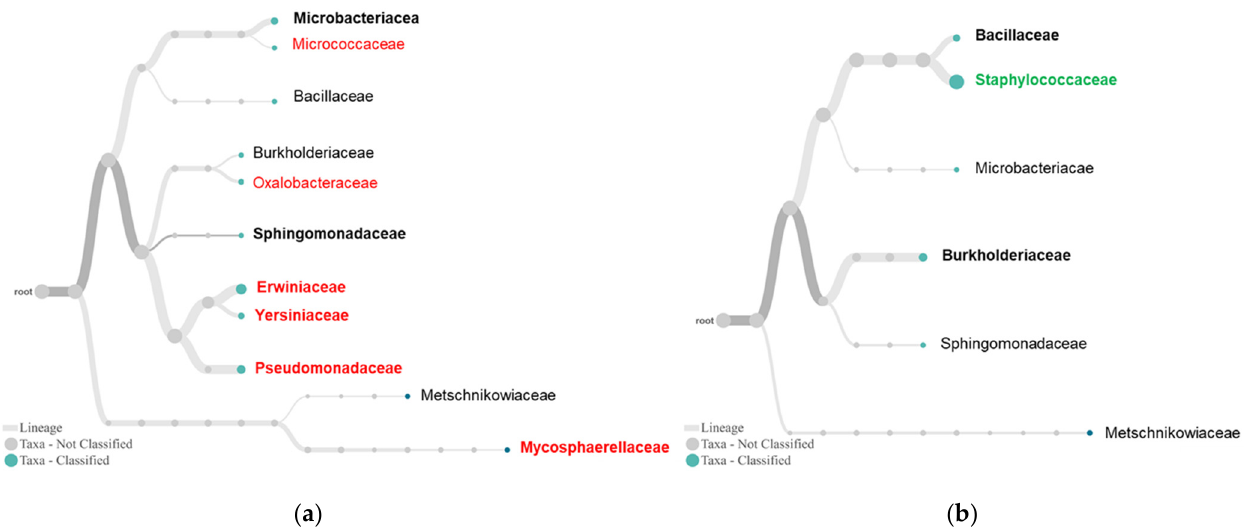
Figure 5. Endophytes in susceptible RfB ( a ) and tolerant VbM ( b ) plants. By default, the trees were constructed with WIMP presenting the top 30 taxa at abundance >1% and a taxonomic rank of family. Taxonomic lineages in bold are predominant in the samples, and those in color are unique to theplant group.